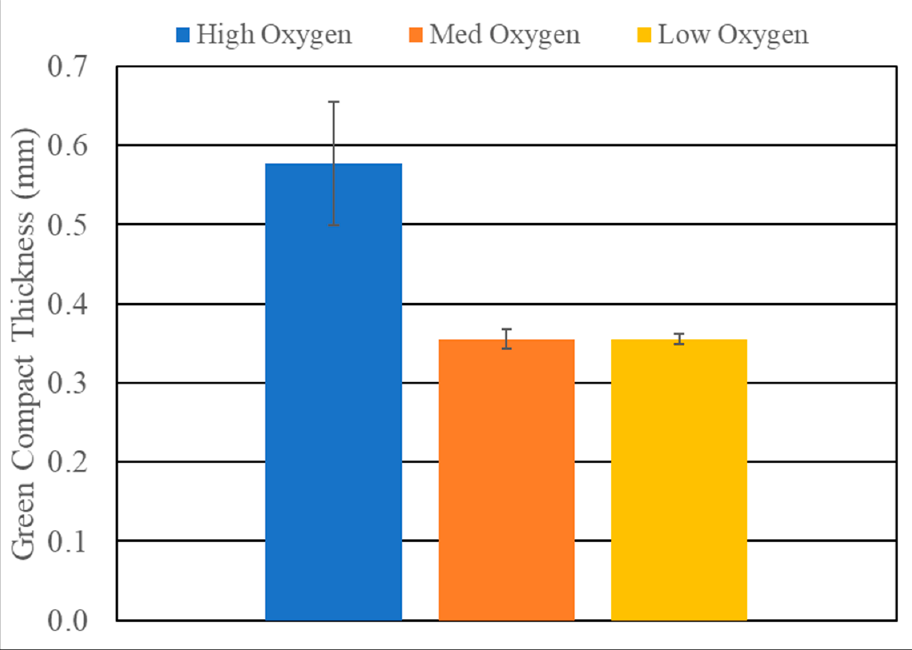
Figure 19. Green body thickness data of impacted green bodies for evaluated AL6061 powders.